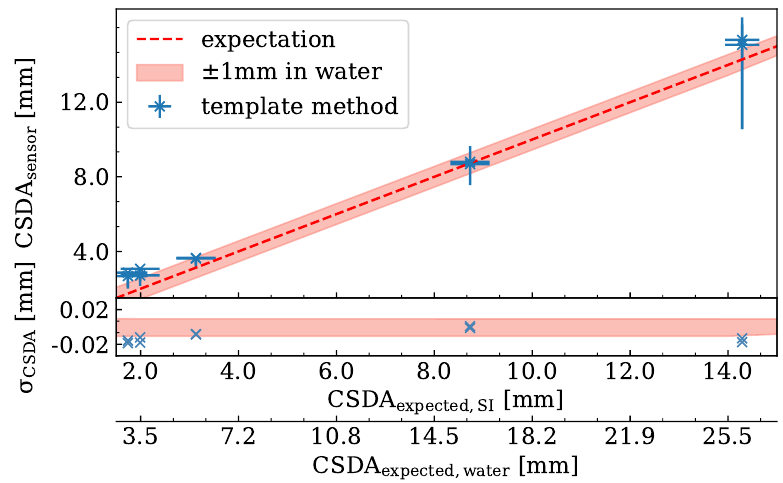
Figure 16. Comparison of CSDA expected, SI for different initial beam energies and the corresponding measured CSDA range CSDA sensor, est estimated by using the template. The red dotted line indicates the expectation and the light red colored interval the deviation ± 1mm of CSDA expected, water . The accuracy of the estimator is illustrated using the parameter σ CSDA